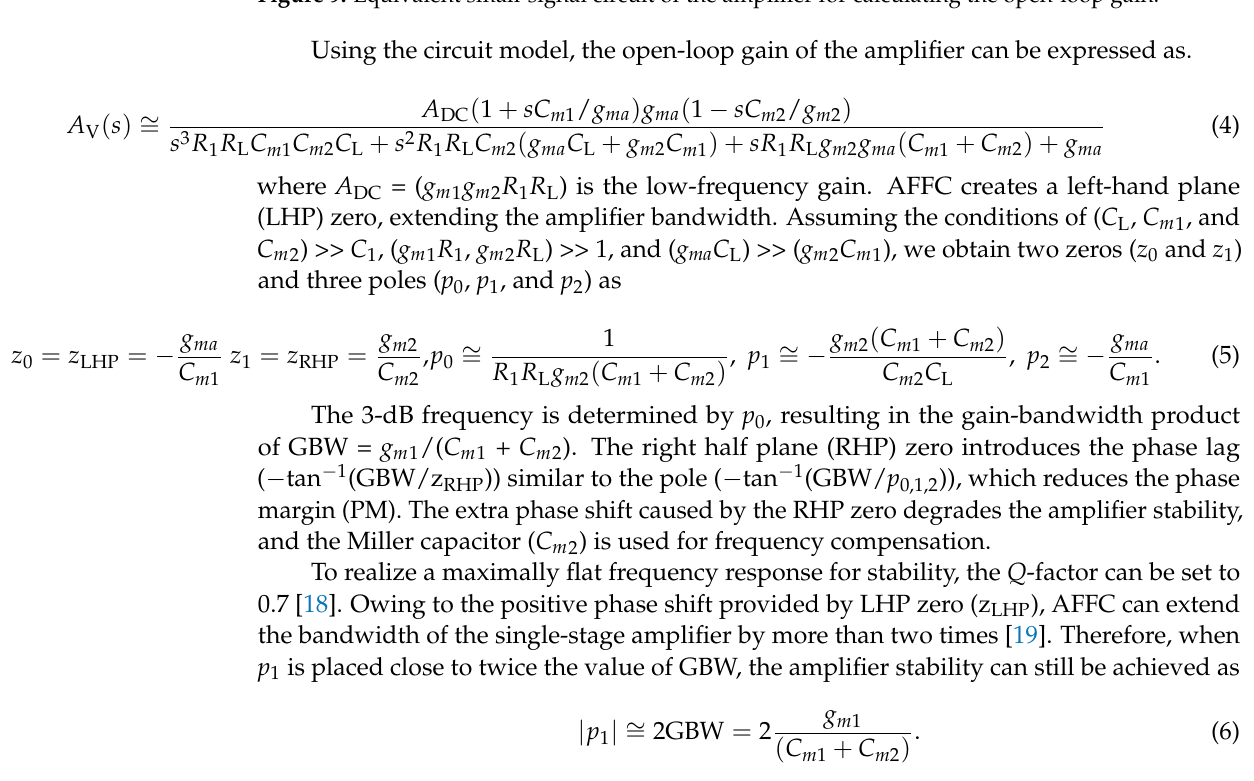
Figure 9. Equivalent small-signal circuit of the amplifier for calculating the open-loop